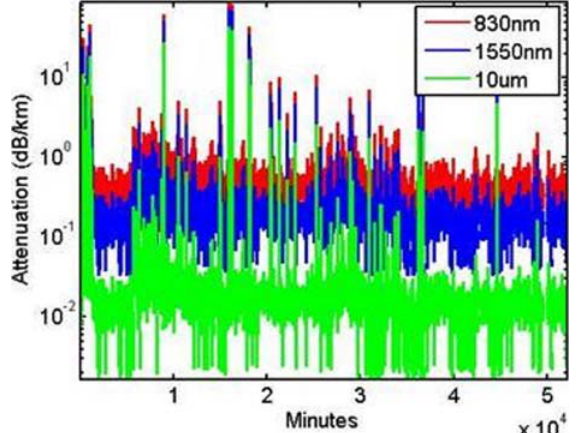
FIG. 10. TIME SERIES PLOT OF VISIBILITY FOR YEAR OF 2012